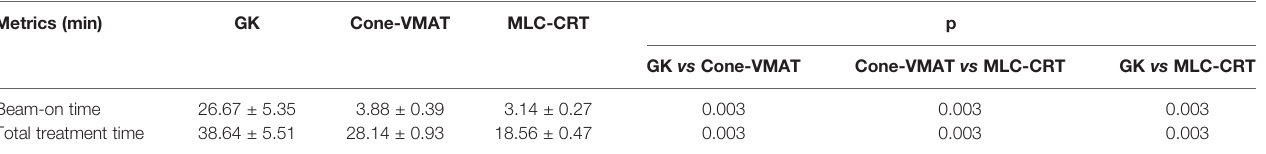
TABLE 4 | Treatment ef fi ciency estimation of different plans. Metrics (min)